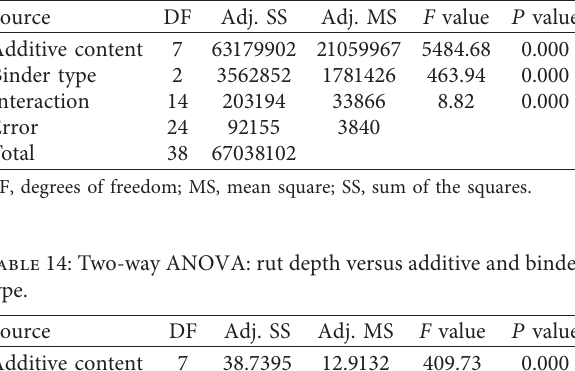
Table 13: Two-way ANOVA: flow number versus additive and binder type. Source DF